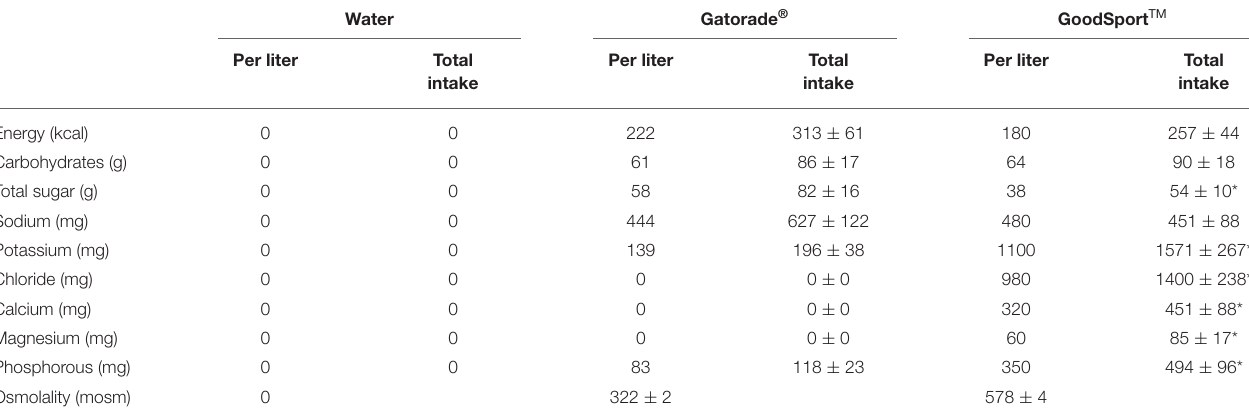
TABLE 2 | Beverage composition and total intake during hot dry condition.